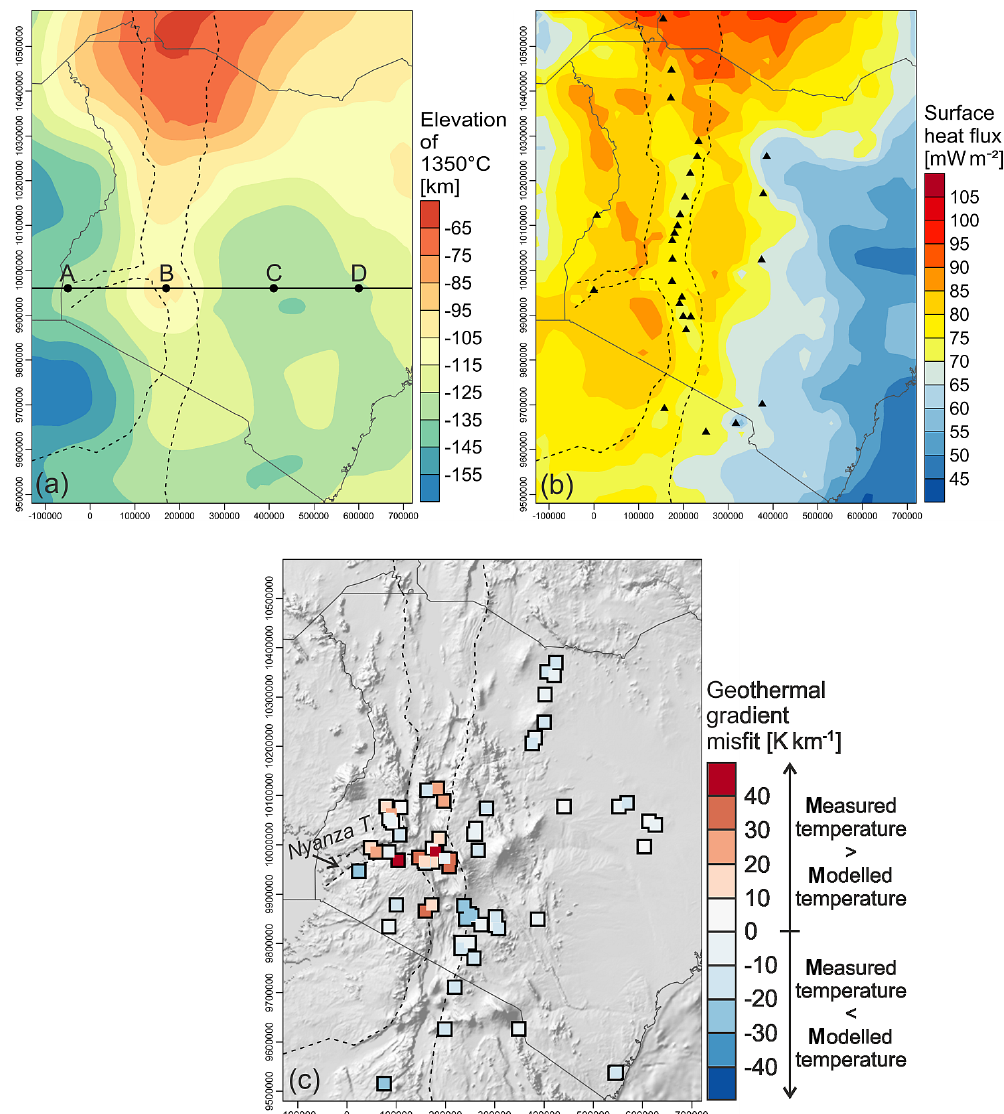
Figure 8. Modelled thermal field. (a) Depth of the 1350 ◦ C isotherm derived from S wave velocity models (Fig. 5b) by following the ap- proach of Priestley and McKenzie (2006) and utilised as the lower thermal boundary condition; black line and points A–D delineate the profile shown in Fig. 9. (b) Calculated surface heat-flux density derived from the 3-D thermal model; locations of volcanoes from the Global Volcanism Program, Department of Mineral Sciences, Smithsonian Institution, http://volcano.si.edu/. (c) Misfits in shallow geothermal gra- dients (measured minus modelled values). The measured geotherms are derived from shallow temperature data covering maximum depth ranges of 280m (databases of Nyblade et al., 1990; Wheildon et al., 1994).